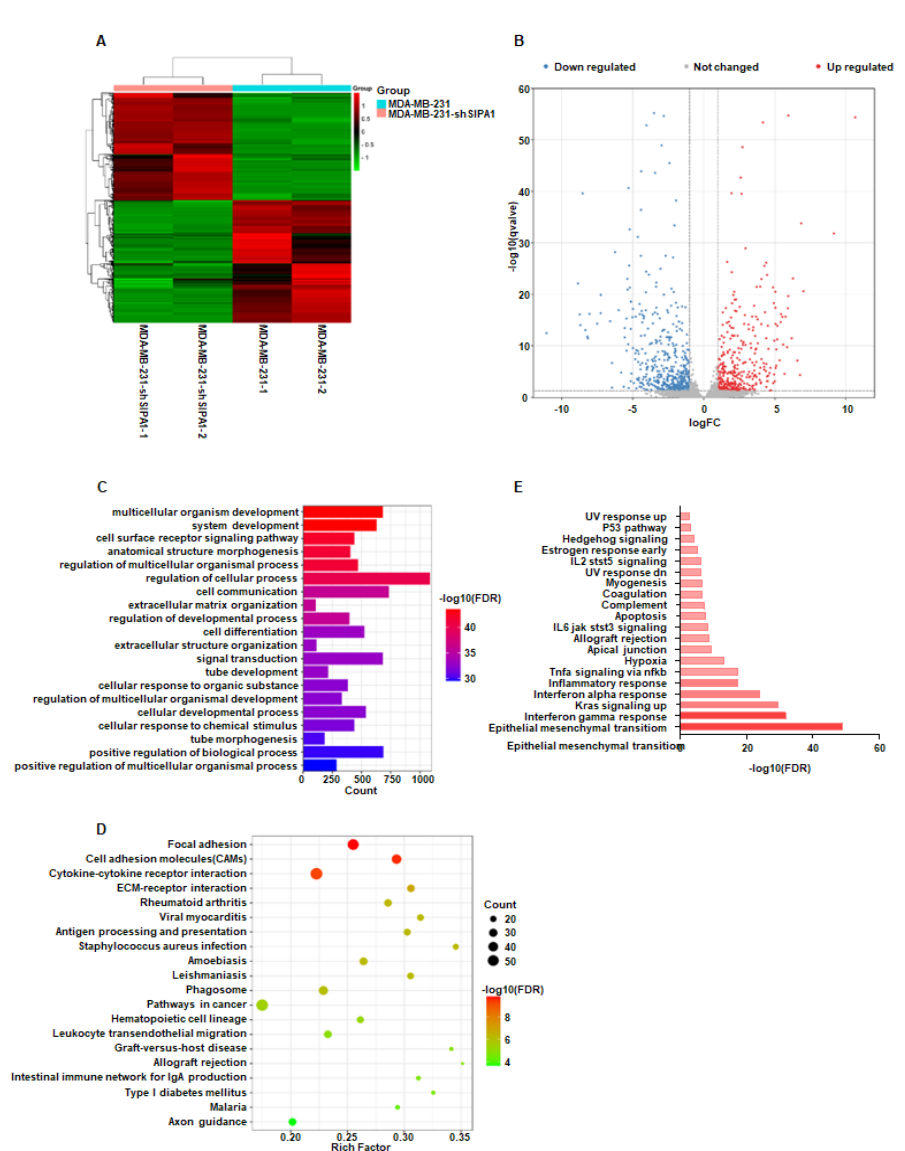
Figure 2. SIPA1 regulates LINC01615 expression . ( A ) Visual heat map of differential lncRNAs. ( B ) Volcanic map of differential lncRNAs. ( C ) Visual bar chart of GO enrichment biological process entries for differential lncRNA co-expression of targeted mRNAs. ( D ) Visualized bubble map of KEGG pathway of differential lncRNAs co-expressing targeted mRNAs. ( E ) Visualized bars of MsigDB landmark genome contrast of different lncRNAs co-expressing targeted mRNAs.